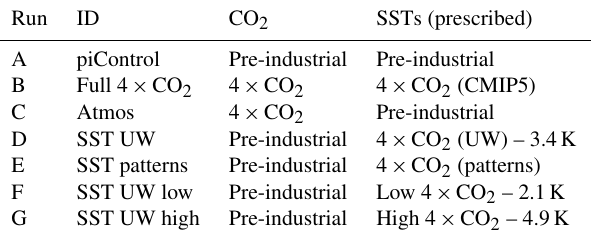
Table 1. The sensitivity experiments used in this study with the atmospheric CO 2 and the SSTs used as boundary conditions. All other boundary conditions are as in